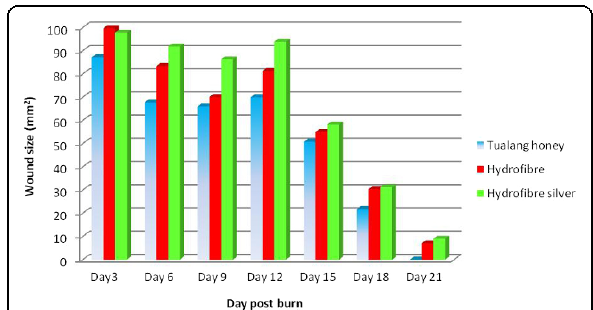
Figure 2 Comparison of wound size among three different dressing materials on burn wounds over time